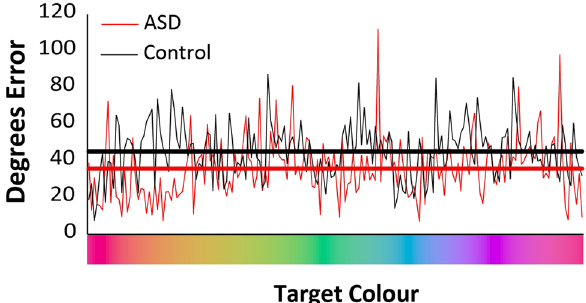
Figure 3. Error by individual colour. Autistic individuals’ higher precision than controls can be seen in their lower average error than controls (heavy lines). No meaningful pattern of error by individual colours was observed (light